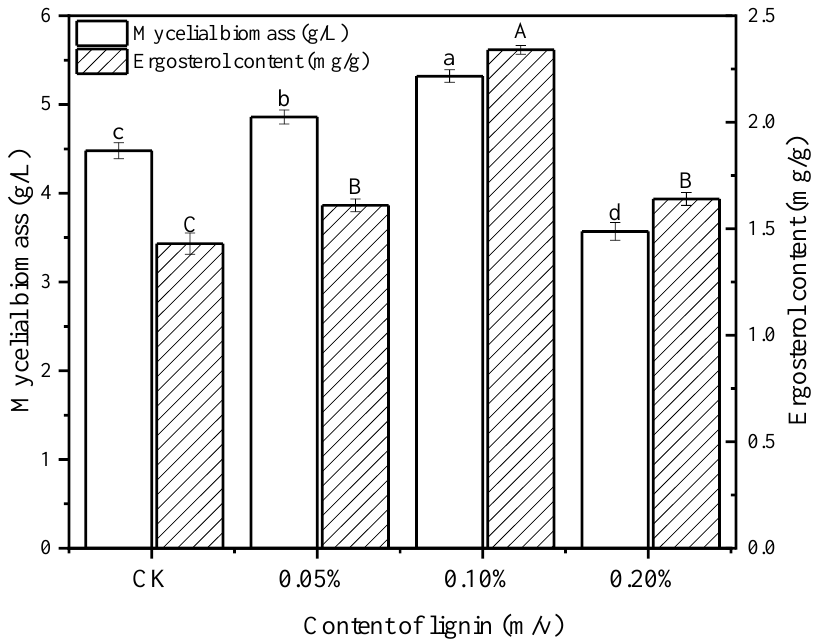
Figure 1. Effect of lignin on mycelial biomass and ergosterol content. Experiments were performed in triplicate, and results are presented as mean ± SD. Different letters (a–d, A–C) represented the significant differences in mycelial biomass and ergosterol content among samples ( p < 0.05). Statistical analysis was carried out by one- way ANOVA accompanied by Duncan’s test using SPSS (ver- sion 20.0).